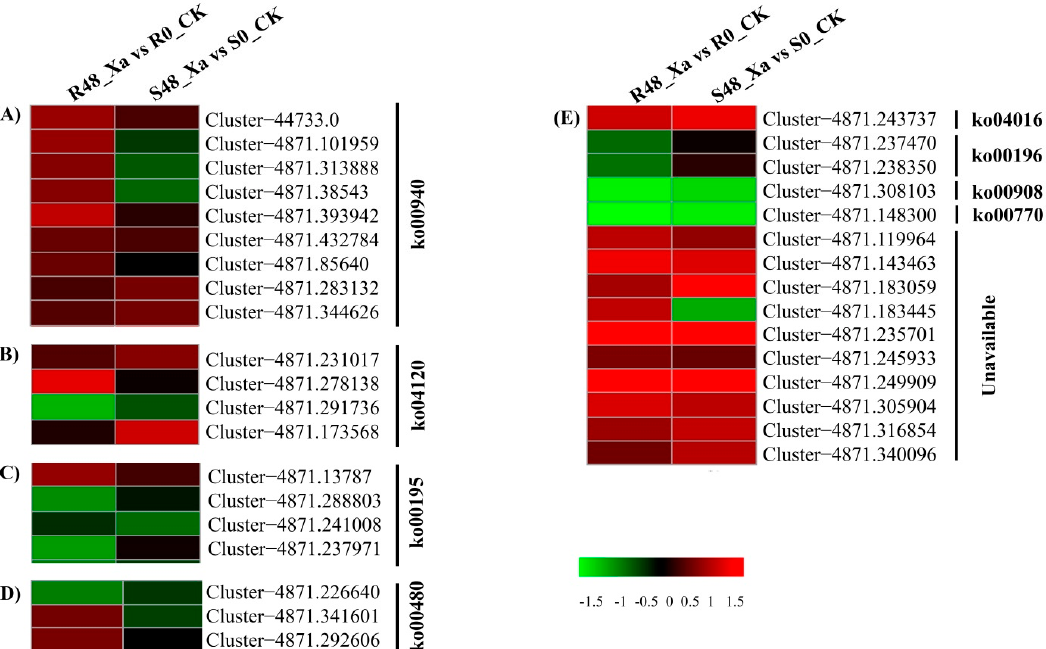
in LCP 85–384 and ROC20 (Supplementary Table S5 and Figure 4).